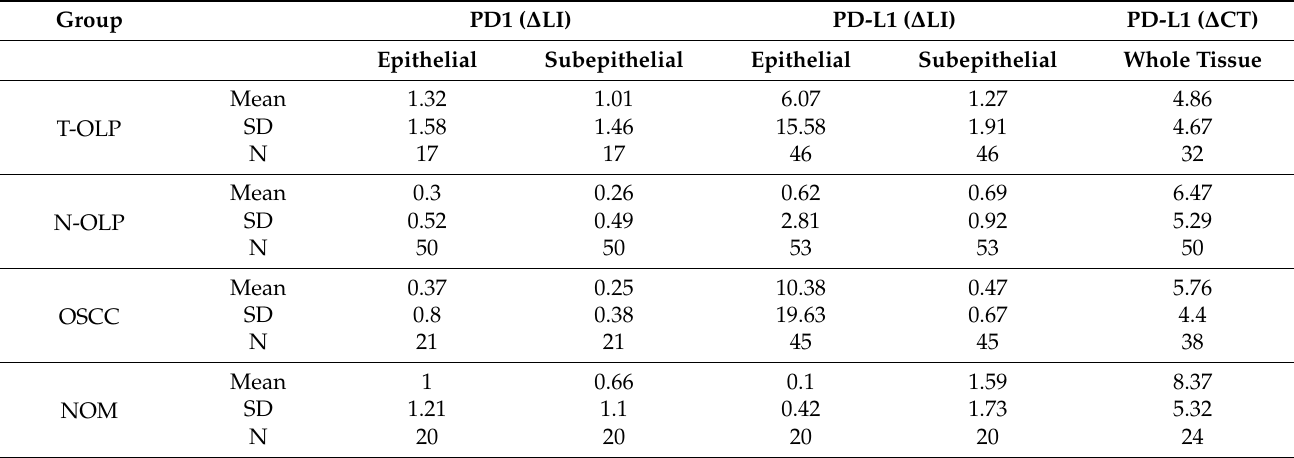
Table 3. Descriptive statistics for average expression rates of ∆ LI and ∆ CT PD-L1 values for all groups determined by immunohistochemistry and